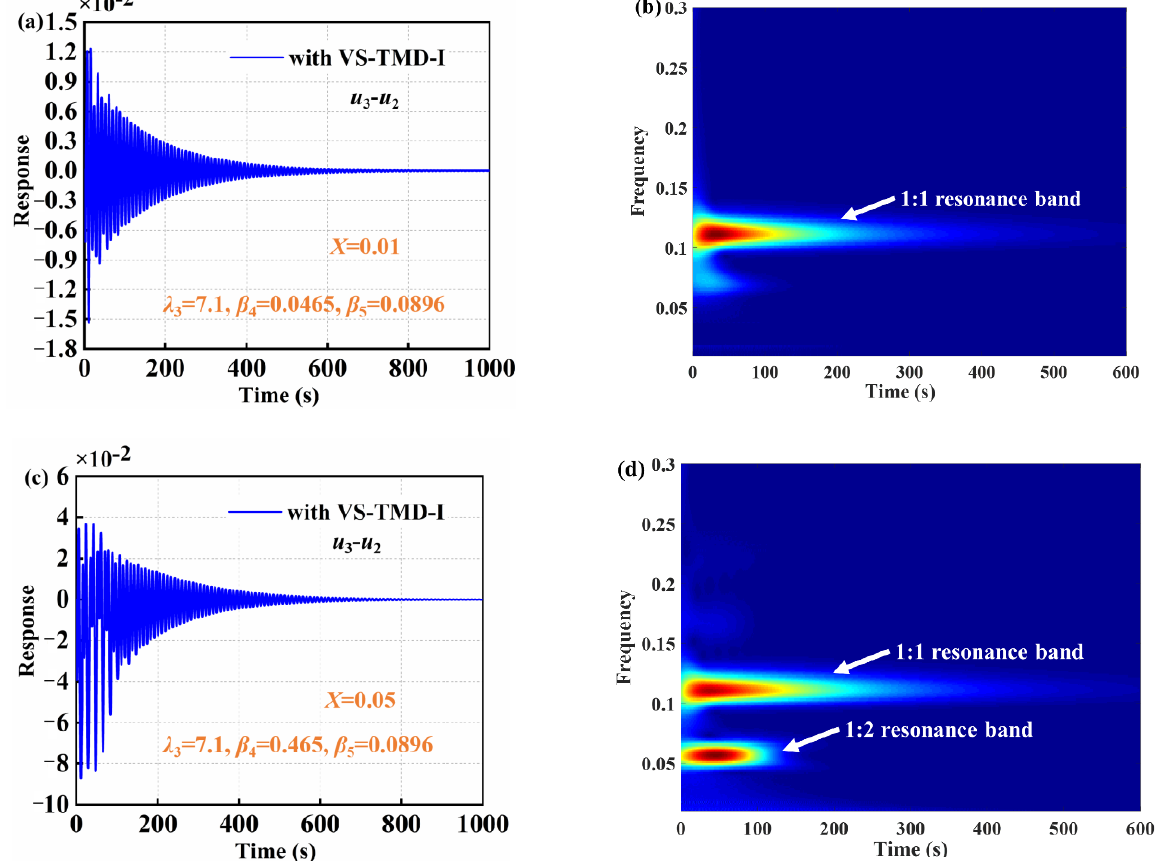
Figure 12. Responses of the relative displacement u 3 - u 2 and the corresponding wavelet transform spectra with various initial impulses: ( a , b ) X = 0.01; ( c , d ) X = 0.05.